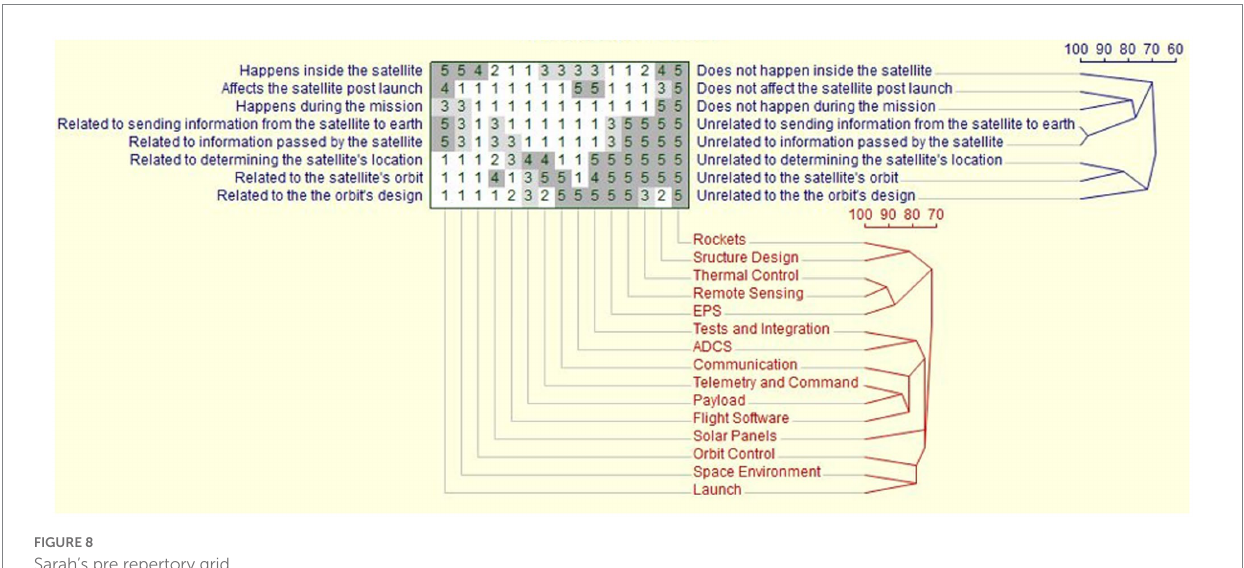
FIGURE 8 Sarah’s pre repertory